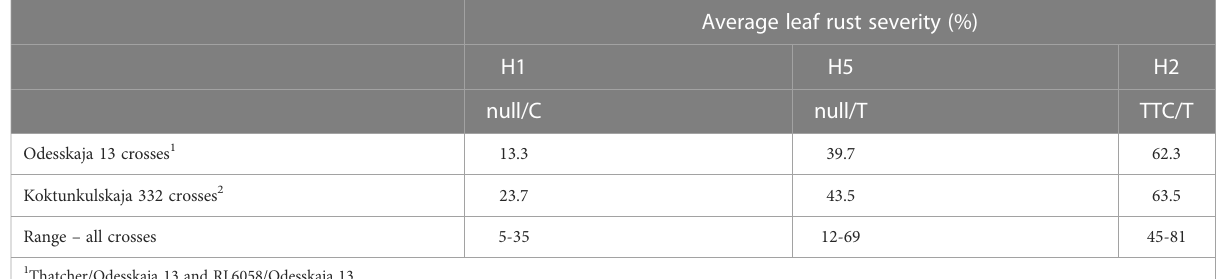
TABLE 1 Leaf rust severity ratings (%) of the Odesskaja 13 and Koktunkulskaja 332 derived near-isogenic line populations based on their Lr34